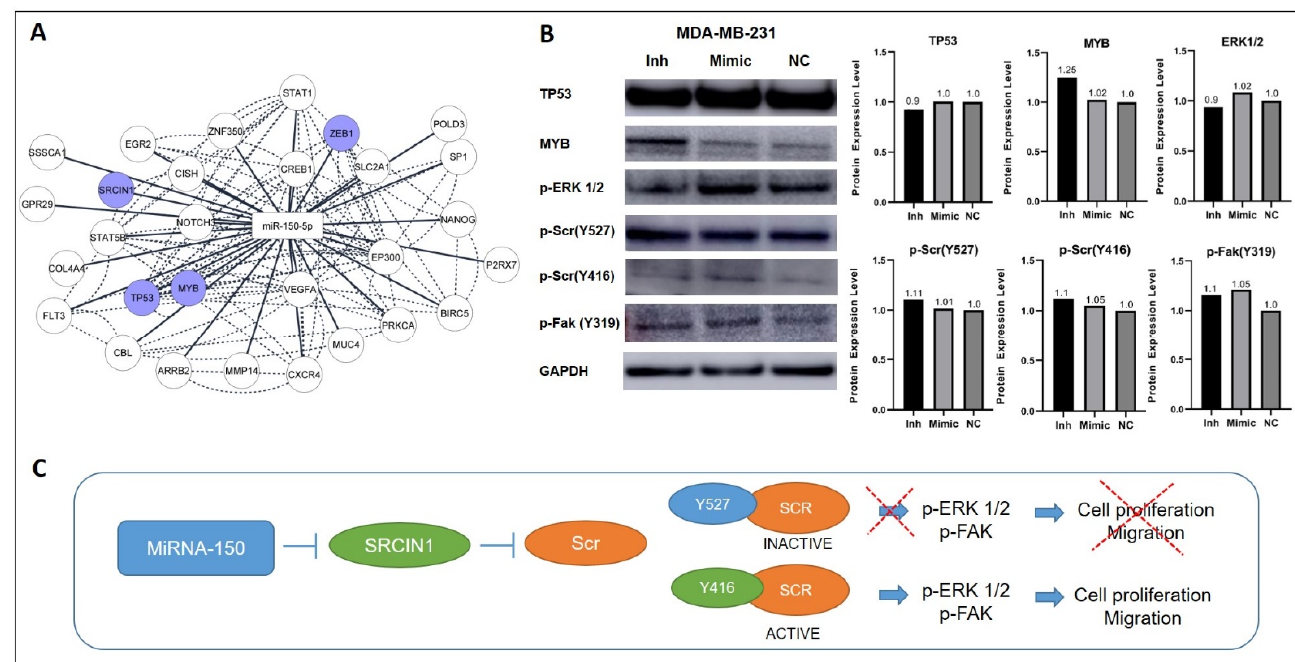
Figure 5. Protein expression analysis of mir-150-5p direct targets and members of the ERK1/2 pathway in the TNBC transfected cells. ( A ) Network of miR-150-5p and experimentally validated target genes (Cytoscape 3.9.1). ( B ) Western blotting and quantitative readings of miR-150-5p mRNA targets and members of the SRC pathway markers in transfected and NC MDA-MB-231 cells. ( C ) Proposed model of miR-150-5p regulation of the SRC pathway. NC: negative control.